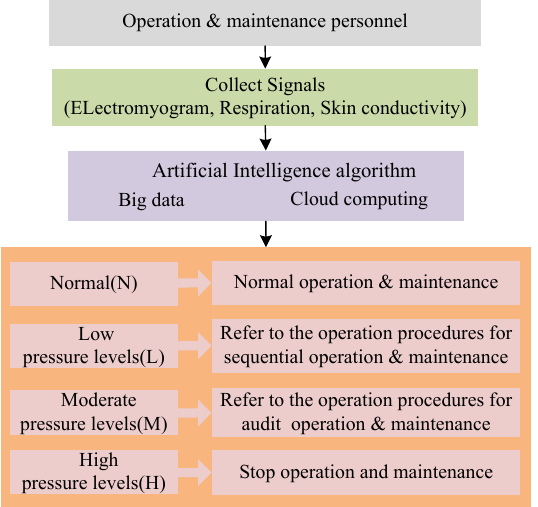
Collect Signals (ELectromyogram, Respiration, Skin